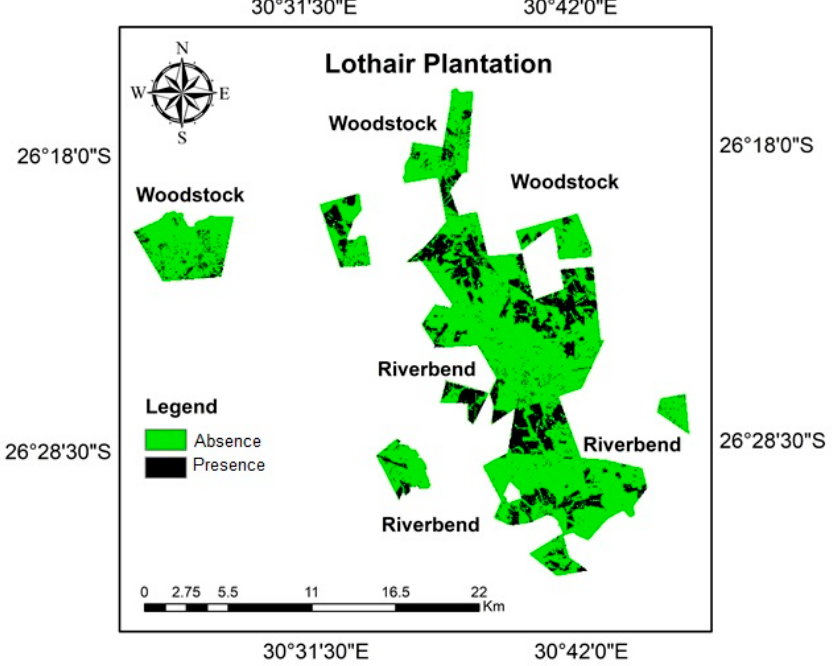
Figure 4. Map of C. tristis occurrence predicted with Maxent models using bands and vegetation indices as indices as predictors.